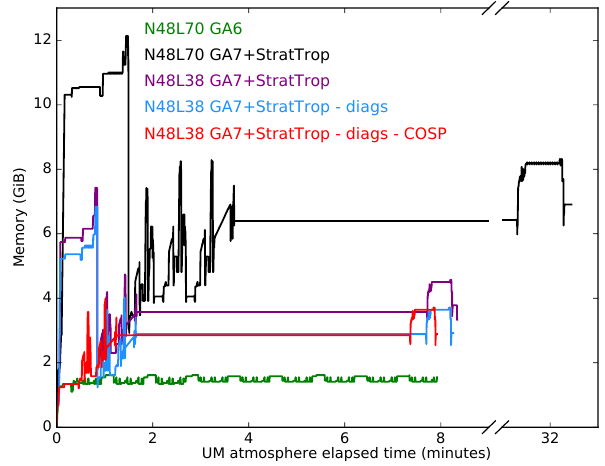
Figure 1. Memory usage of various UM configurations on the VM. Each simulation was performed using 1 MPI process without using OpenMP parallelisation. Further details of these different configu- rations are given in Table